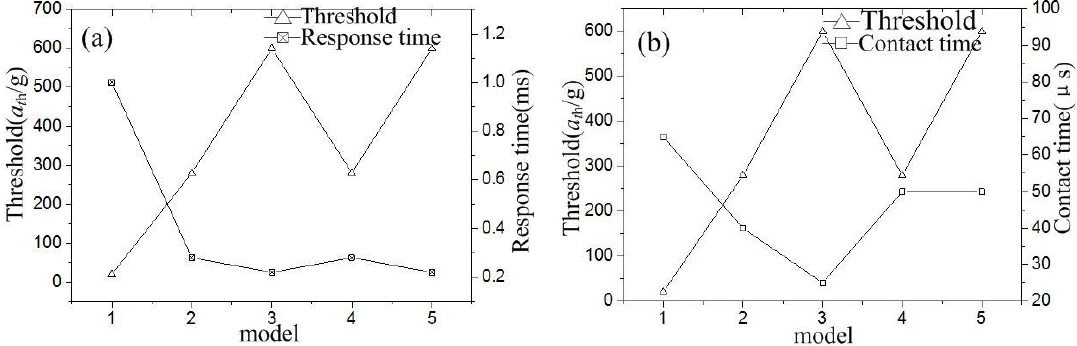
Figure 8. ( a ) Relationship between response time and threshold. ( b ) Relationship between contact time and threshold. and